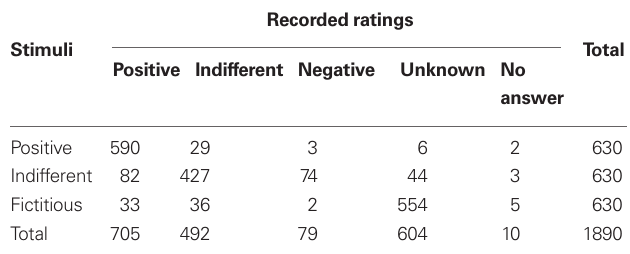
Table 1 | Assessments made during the scanning sessions separated according to the type of stimuli.